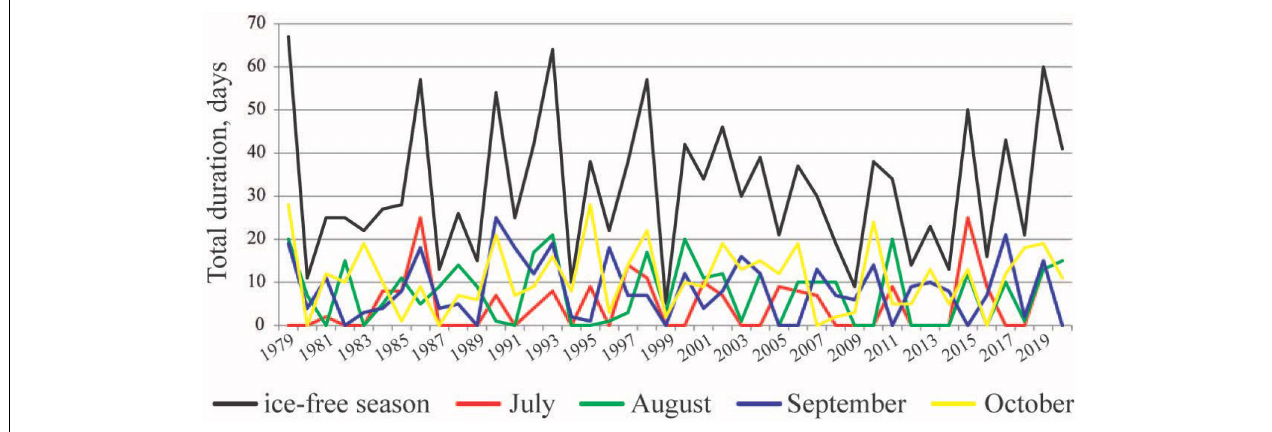
FIGURE 11 | Total annual durations of upwelling-induced distant inflow periods calculated from the ERA5 atmospheric reanalysis during July (red line), August (green line), September (blue line), October (yellow line), and during the whole ice-free season (black line) in 1979–2020. Note that these estimations are based on wind data and not based on in situ